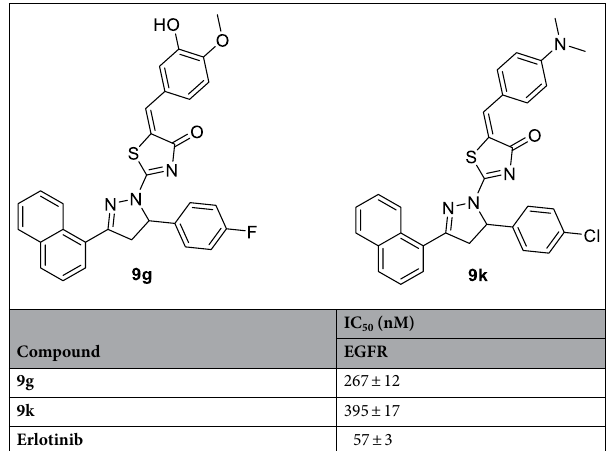
Table 2. In vitro inhibitory activity of hybrids 9g and 9k towards EGFR.